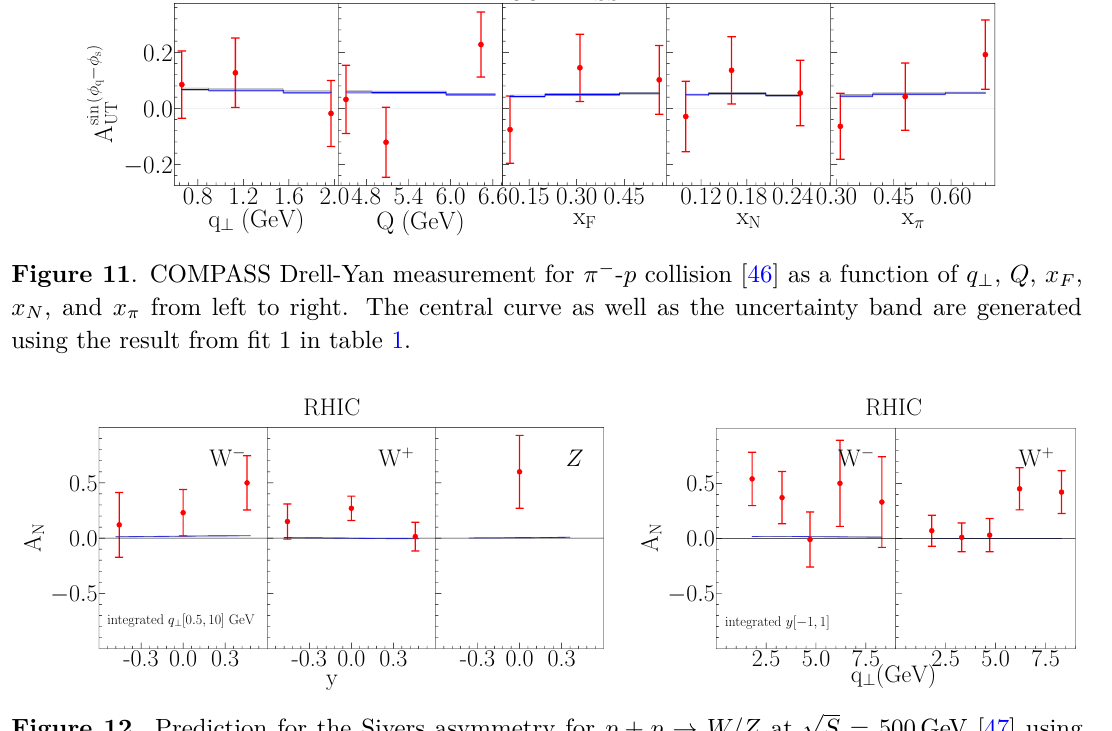
Figure 12 . Prediction for the Sivers asymmetry for p + p → W/Z at the result of fit 1 in table 1. We plot only the central curve from fit 1 here since the size of the uncertainty band is small for this prediction. Left: the y dependent data integrated in q ⊥ from 0 . 5 to 10 GeV. Right: the q ⊥ dependent data integrated in y from − 1 to 1